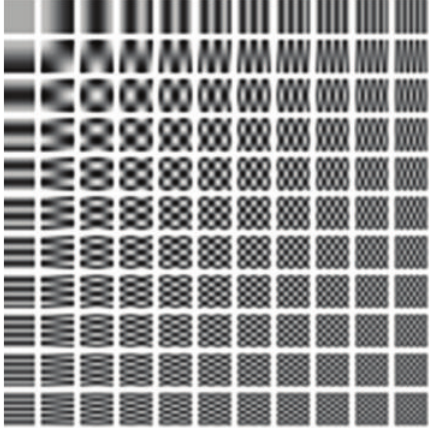
Figure 5: Two-dimensional discrete cosines basis. Each square in the 11 × 11 array is a 2D function representing a basis